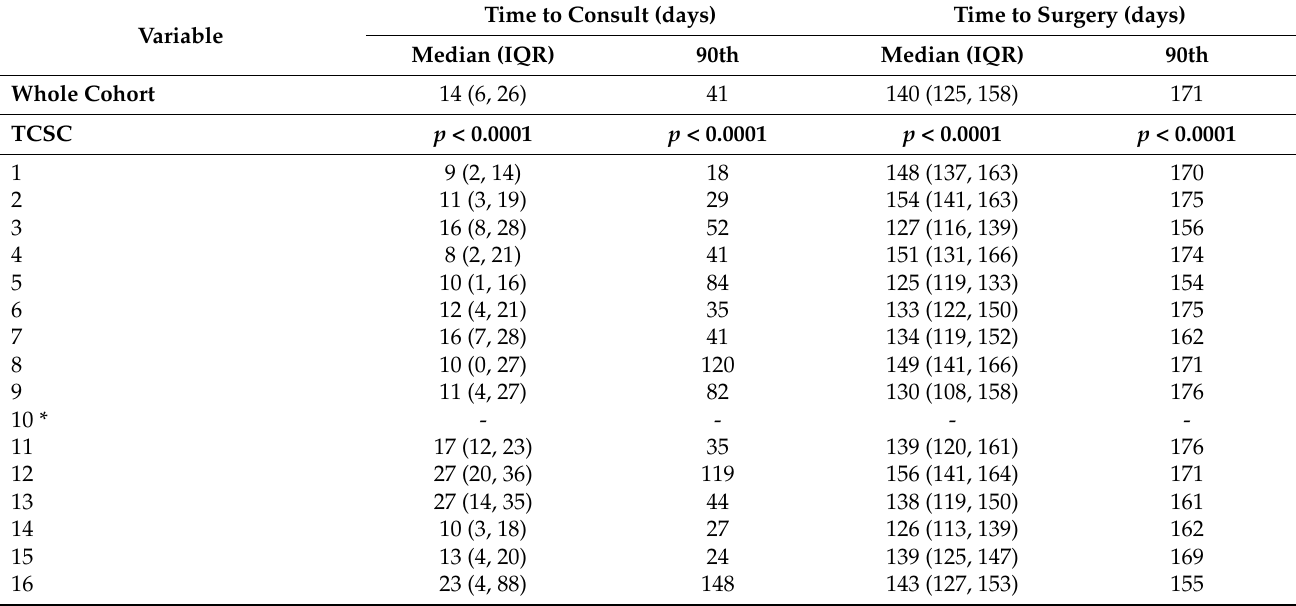
Figure 2. Bar chart depicting the distribution of the time to surgery for esophageal cancer in Ontario between 2013 and 2018. Table 2. Time to surgical consult and time to surgery (days) at the 50th and 90th percentiles according to the categories of associated factors in Ontario patients with esophageal cancer between 2013 and